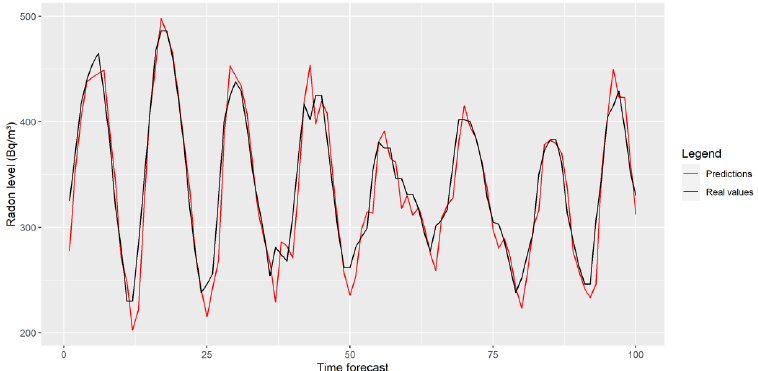
Figure 10. Radon forecasting for winter 2021.